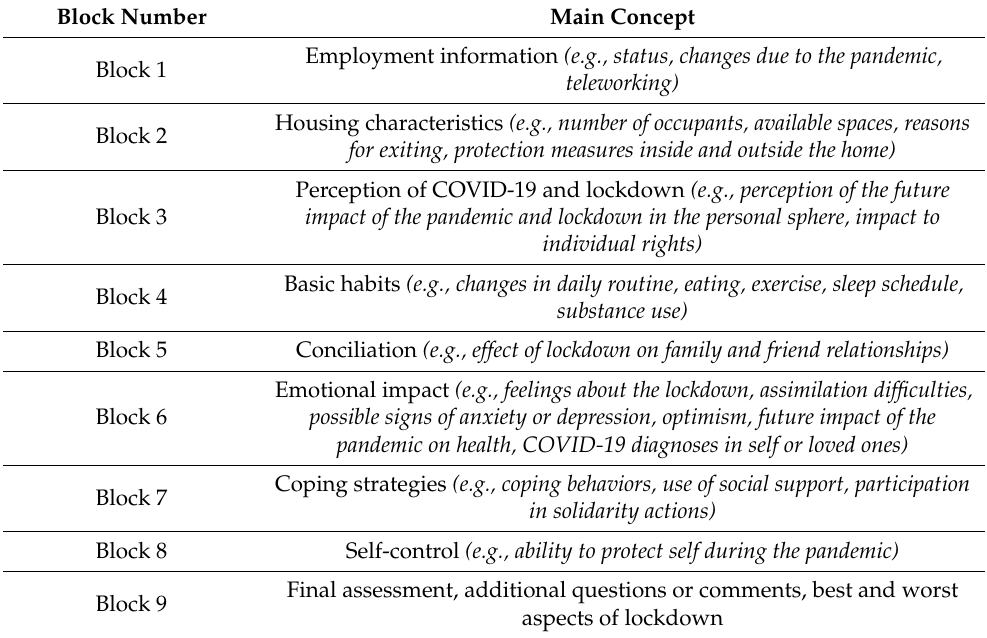
Table A1. Description of subject areas for the semi-structured interview questions. Block